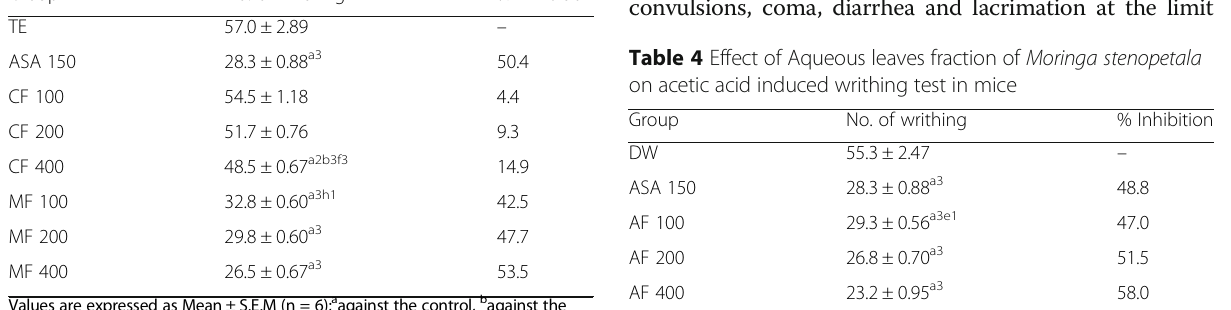
Table 3 Effect of methanolic and chloroform fractions of leaf of Moringa stenopetala on acetic acid induced writhing test in mice Group